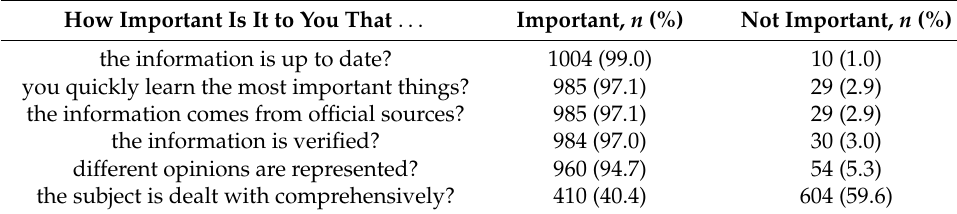
Table 3. Responses on information accuracy concerns.